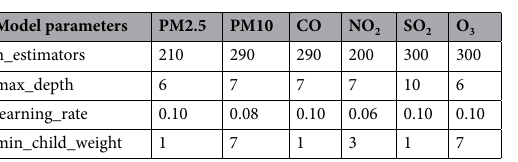
Table 4. Six types of pollutant concentration prediction model parameters.